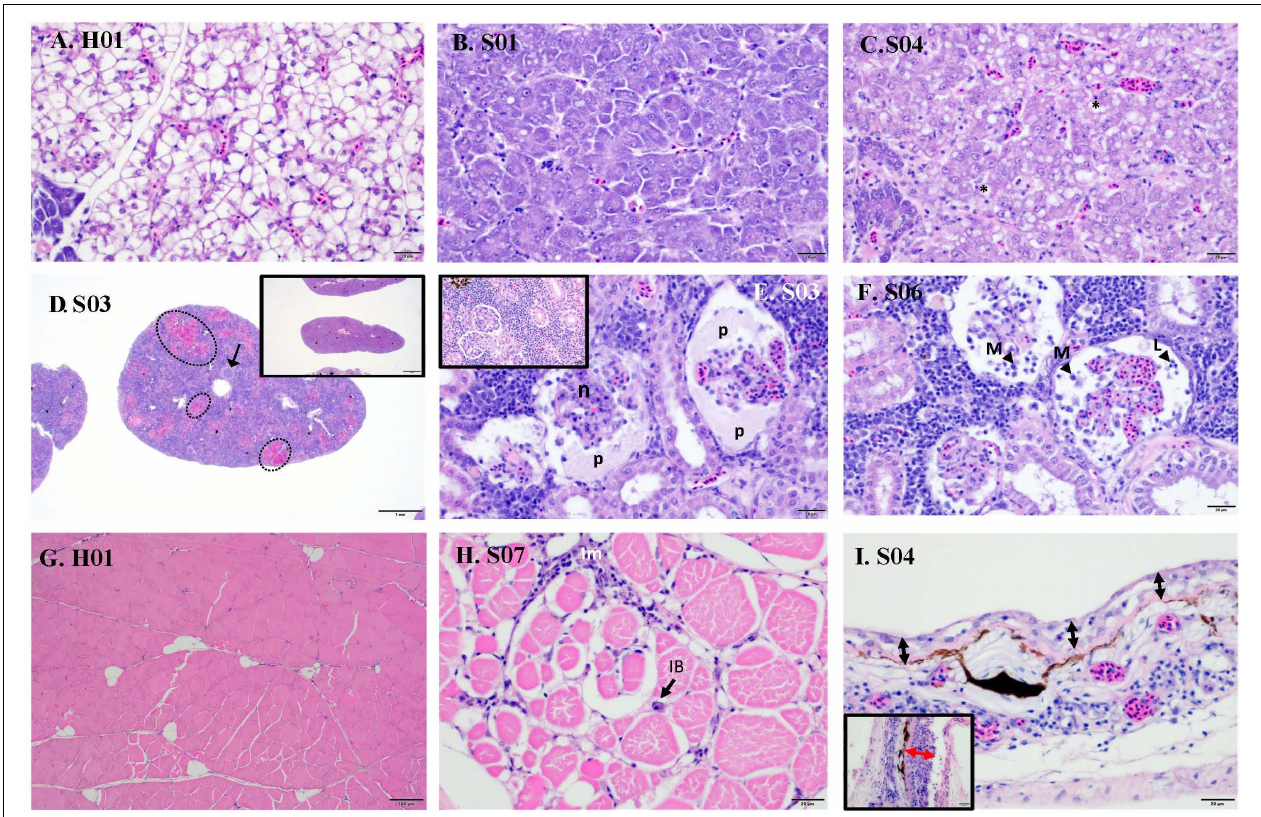
FIGURE 2 | Histopathology of sick (S) and healthy (H) barramundi (hematoxylin and eosin stains). (A) Liver, wispy cytoplasmic appearance due to good levels of lipid reserves (fish H01). (B) Liver, homogenous, basophilic cytoplasm with low lipid reserves (fish S01). (C) Liver, severe hepatic lipidosis, with large lipid vacuoles or macrovesicles (*) (fish S04). (D) Spleen, moderate splenitis with multifocal necrosis (encircled, fish S03). Arrow shows occluded artery. Inset is spleen with no abnormalities (fish H06). (E) Kidney, severe glomerulonephritis, with pyknosis and karyorrhexis [necrosis (n)] and protein effusion (p) into Bowman’s space (fish S03). Inset is kidney with no abnormalities (fish H01). (F) Kidney, severe glomerulonephritis with glomerular necrosis and infiltration into Bowman’s space of macrophages (M) and lymphocytes (L) (fish S06). (G) Normal skeletal muscles (fish H01). (H) Interstitial myositis (Im), associated with occasional viral inclusion body (IB) (fish S07). (I) Thinning of epidermis (black arrow) (Fish S04), compared with thicker epidermis (red arrow) (inset, fish H01). Lymphocytic-monocytic infiltration surrounding dermal blood